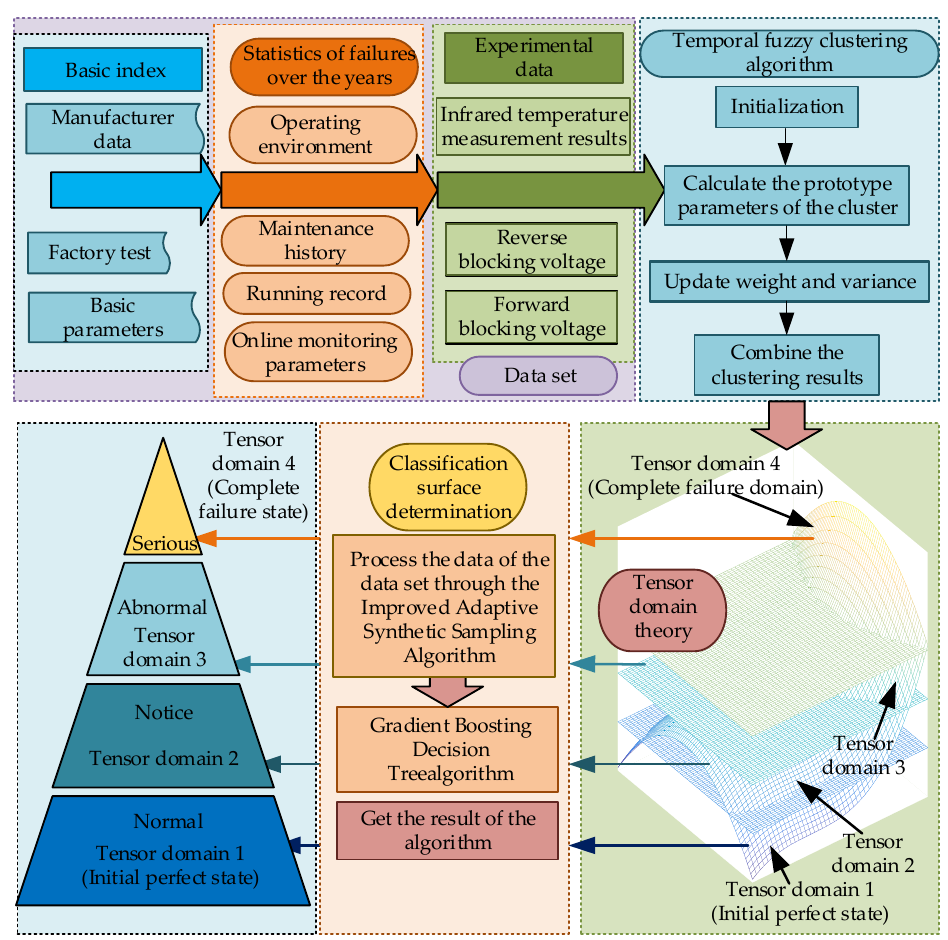
Figure 6. Flow chart of the STDC thyristor evaluation method.